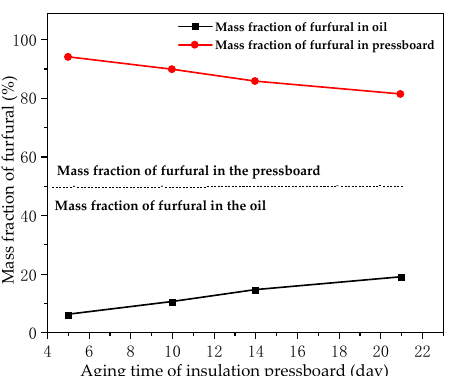
Figure 10. Mass fraction of furfural in groups composed of new oil and pressboard with different aging degrees.